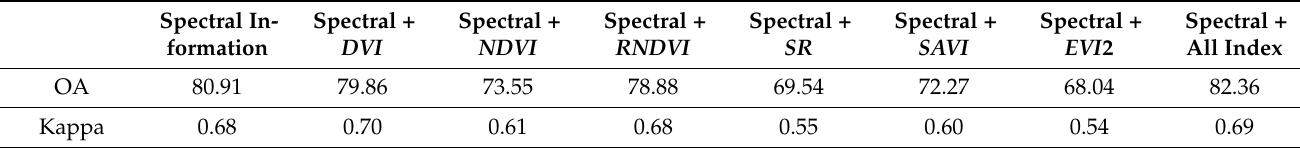
Table 5. Classification results using the k-means classifier.